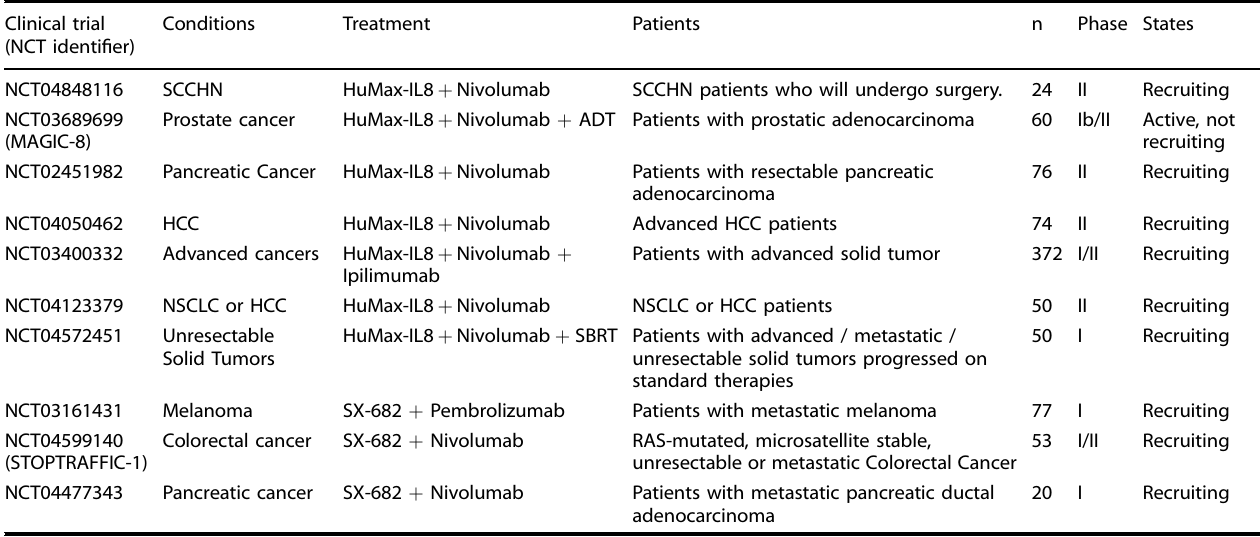
SCCHN Head and neck squamous cell carcinoma, ADT androgen deprivation therapy, HCC hepatocellular carcinoma, NSCLC non-small cell lung cancer, SBRT stereotactic body radiotherapy All data are from ClinicalTrials.gov, accessed May